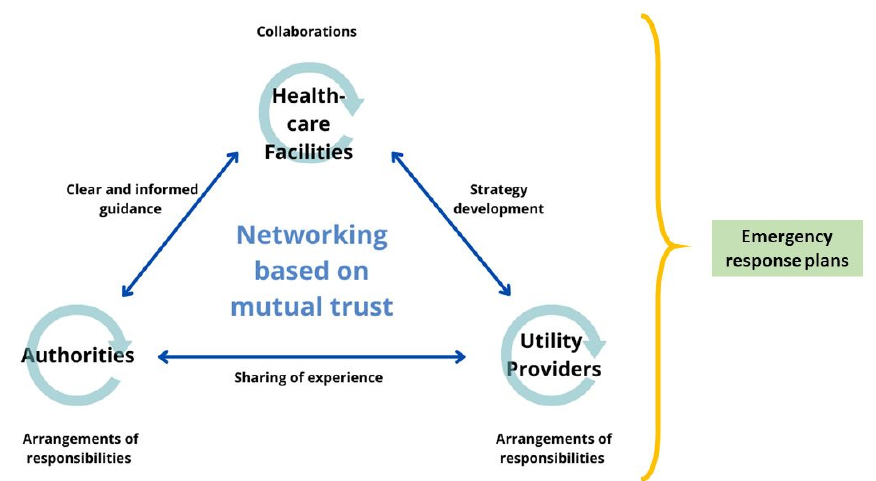
Figure 3. Example of a network between healthcare facility management, authorities, and utility providers to build a foundation to create and implement emergency response plans.